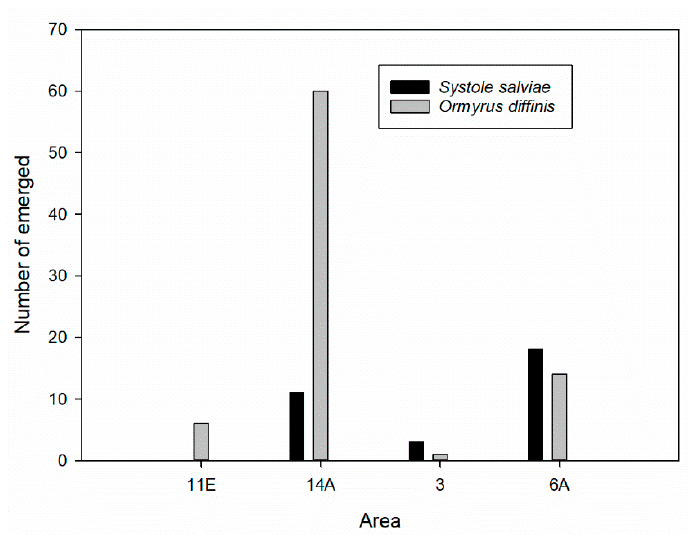
Figure 5. Emergence of S. salvia and O. diffinis during the summer and autumn seasons. The percentage of seeds attacked by the seed feeders was different in relation to the site, with the minimum in site 6 (0.86%) and the maximum in site 3 (5.71%). Two insect species emerged from the sage seeds: Systole salviae (Zerova, 1968) (Hymenoptera, Chal- cidoidea, Eurytomidae) and Ormyrus diffinis (Fonscolombe, 1832) (Hymenoptera, Chal- cidoidea, Ormyridae). The species that emerged were different among the sites, with a preponderance of O. diffinis in site 14 and the absence of S. salviae emergence in site 11 (Figure 6).